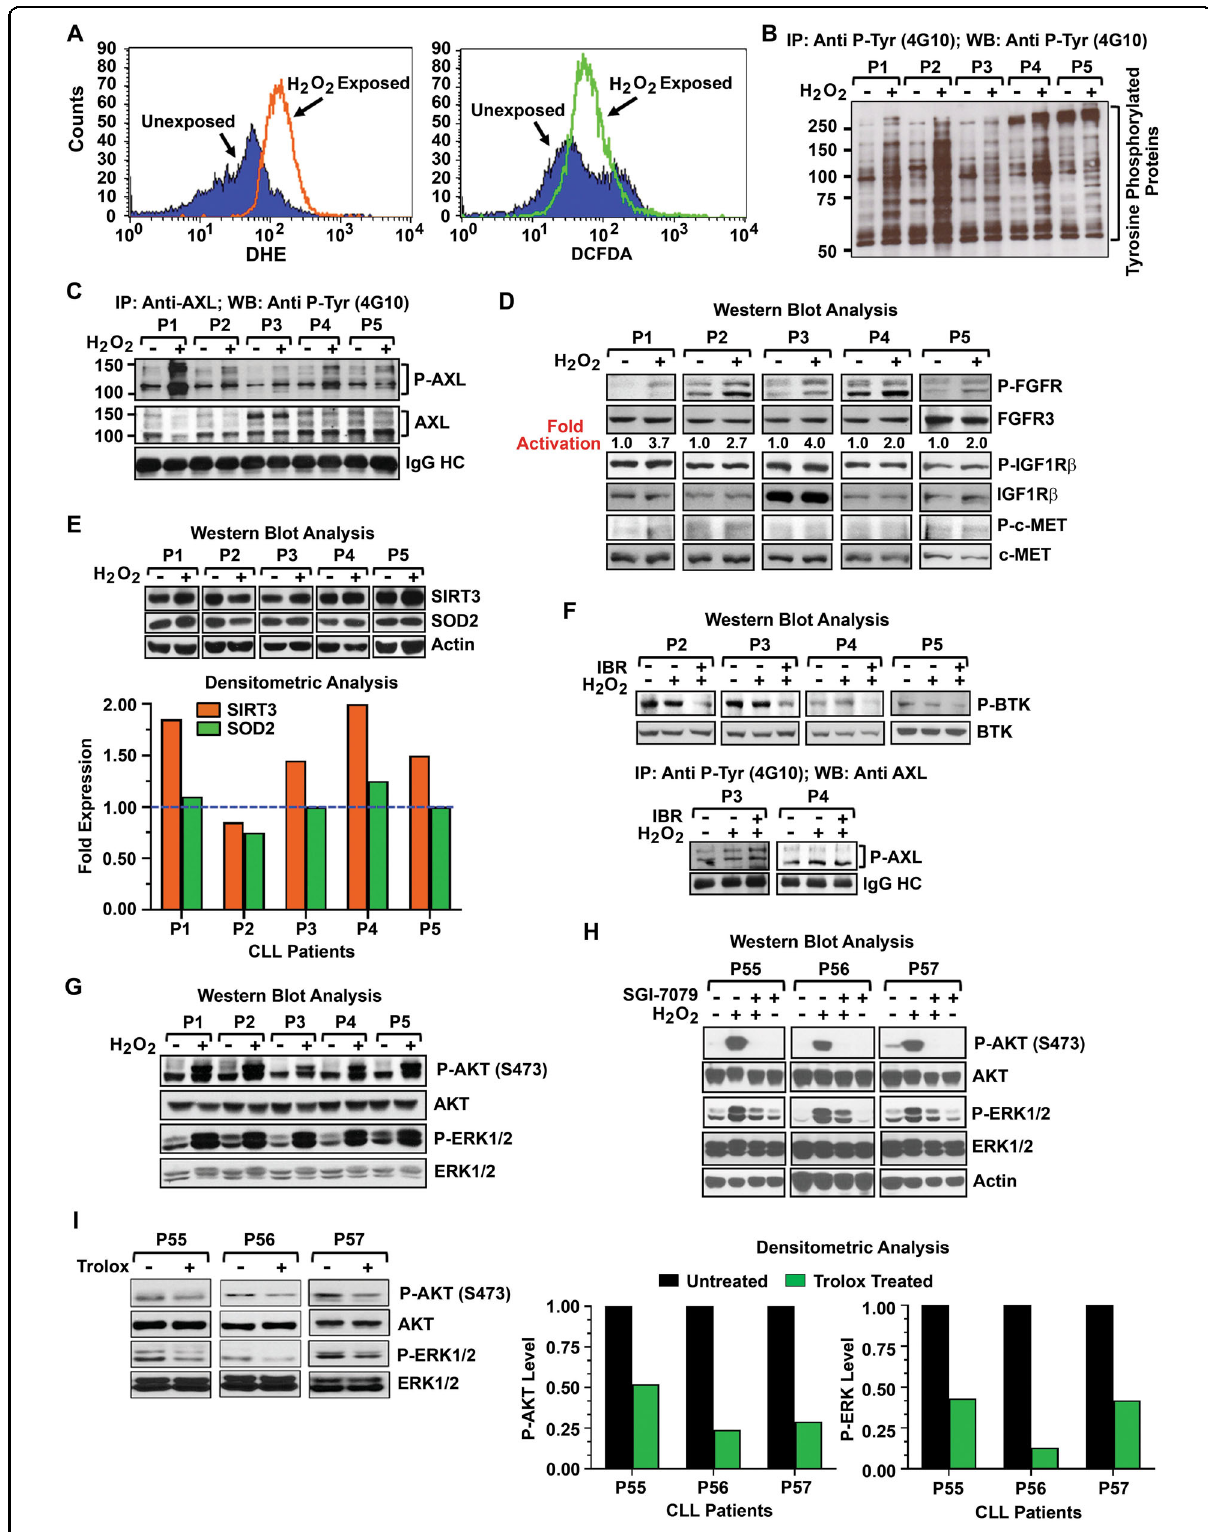
Fig. 5 (See legend on next